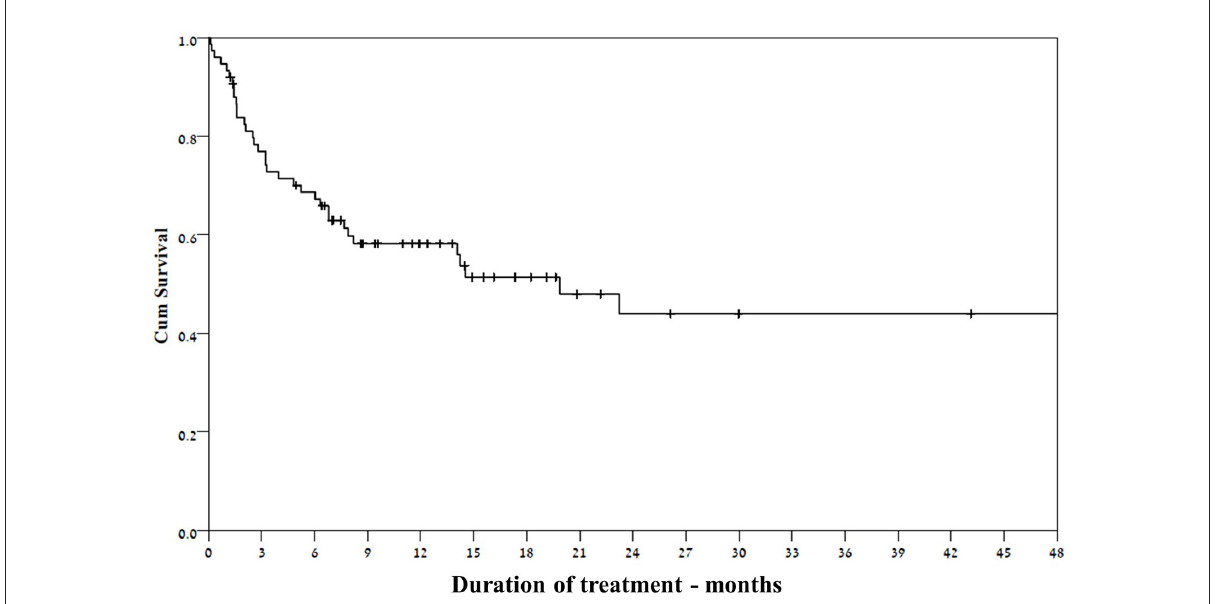
FIGURE3 Kaplan- Meier curve of patients continuing treatment with felbamate over